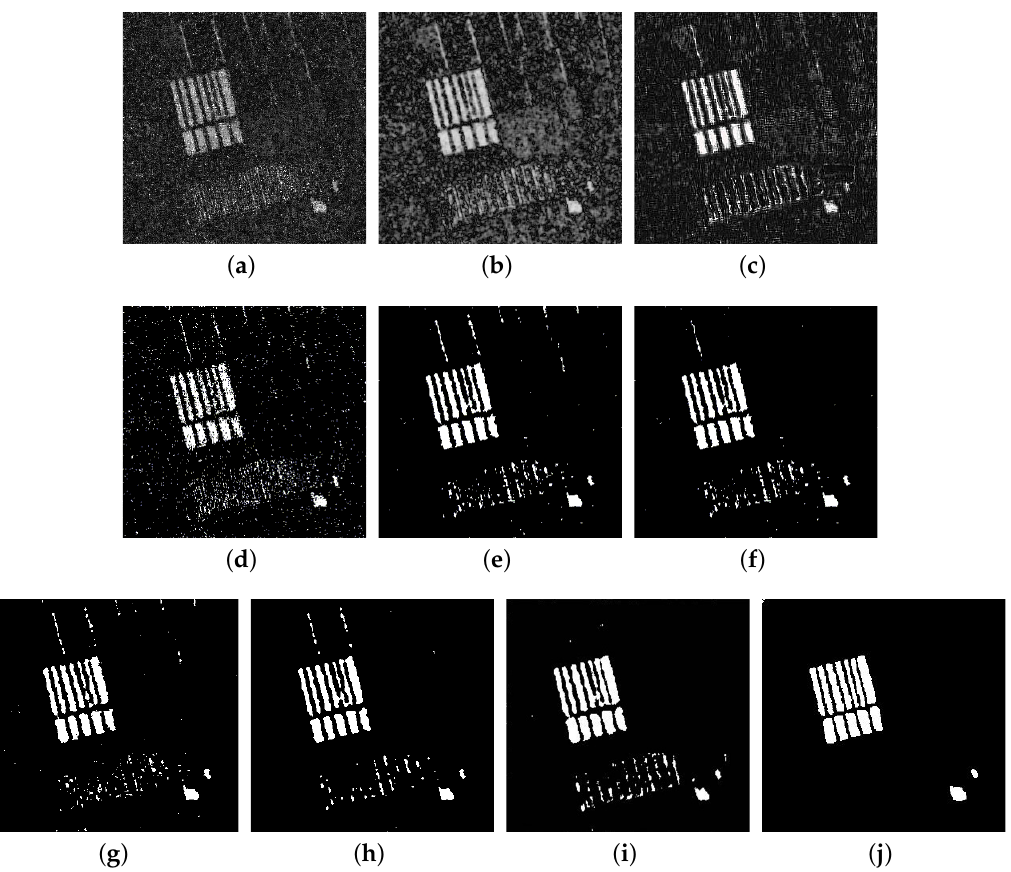
Figure 13. Difference maps and resulting maps of the farmland dataset obtained by different methods. ( a ) Difference map by the log-ratio (LR). ( b ) Difference map by the mean-ratio (MR). ( c ) Difference map by SCCN. ( d ) Resulting map by LR. ( e ) Resulting map by MR. ( f ) Resulting map by SCCN. ( g ) Resulting map by DCAPSbased on LR (D_LR). ( h ) Resulting map by DCAPS based on MR (D_MR). ( i ) Resulting